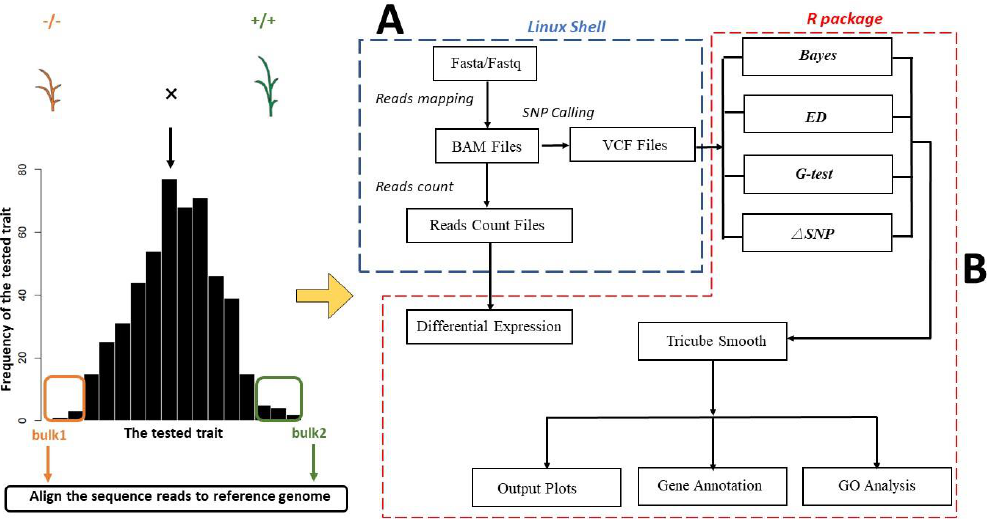
Figure 1. Flow chart for using R package: ( A ) The script flow running on the Linux shell system. This script will produce the VCF file, which includes NGS-SNP information, as a PNGSeqR input file. ( B ) The main statistics and functions in PNGSeqR.